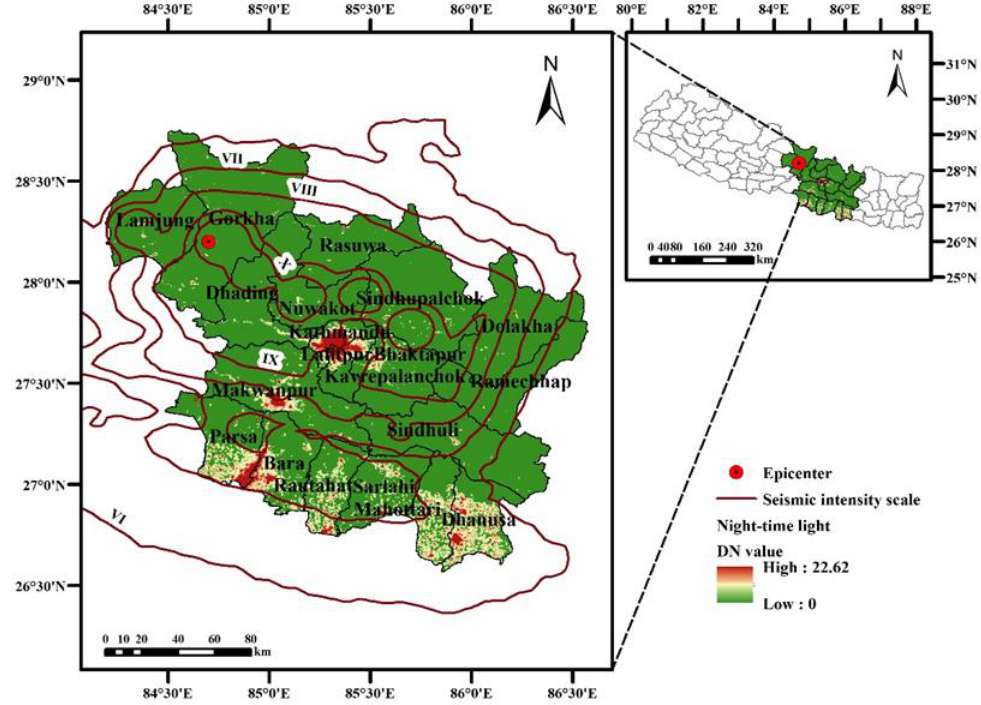
Figure 1. The study area. The image is the study area composed of the National Polar-Orbiting Partnership Satellite Visible Infrared Imaging Radiometer Suite (NPP / VIIRS) monthly data acquired in April 2015. The digital number (DN) value of NPP / VIIRS shows the intensity of human activity (HA).